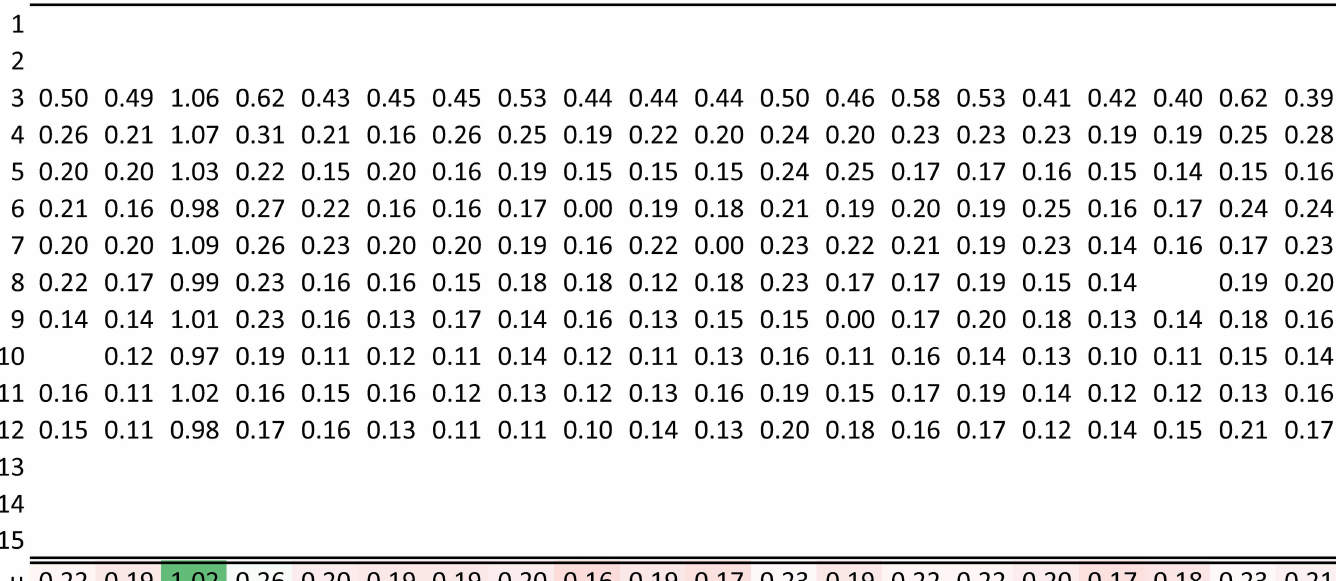
Fig 4. Example of selectivity tables. Tables showingsubstitutionvalues of residue 518D of humanserum albuminagainstall 20 amino acids (columns)and being representedin 10 out of 15 positionsof the overlappingpeptides (rows). Entire blank rows depict the native residue being represented in peptides with no positive signal. Individual blank cells are missing data. The row μ shows the mean substitutionvalue of the replacingamino acids. Here, cells are highlightedby the effect of substitutionas a color gradientfrom red to green through white, where white corresponds to the globalmean, μ g , equal to 0.240.